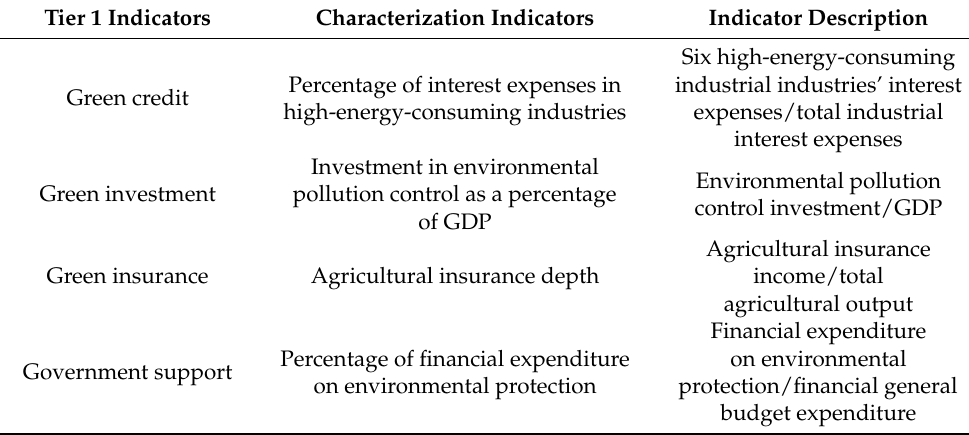
Table 1. Green Finance